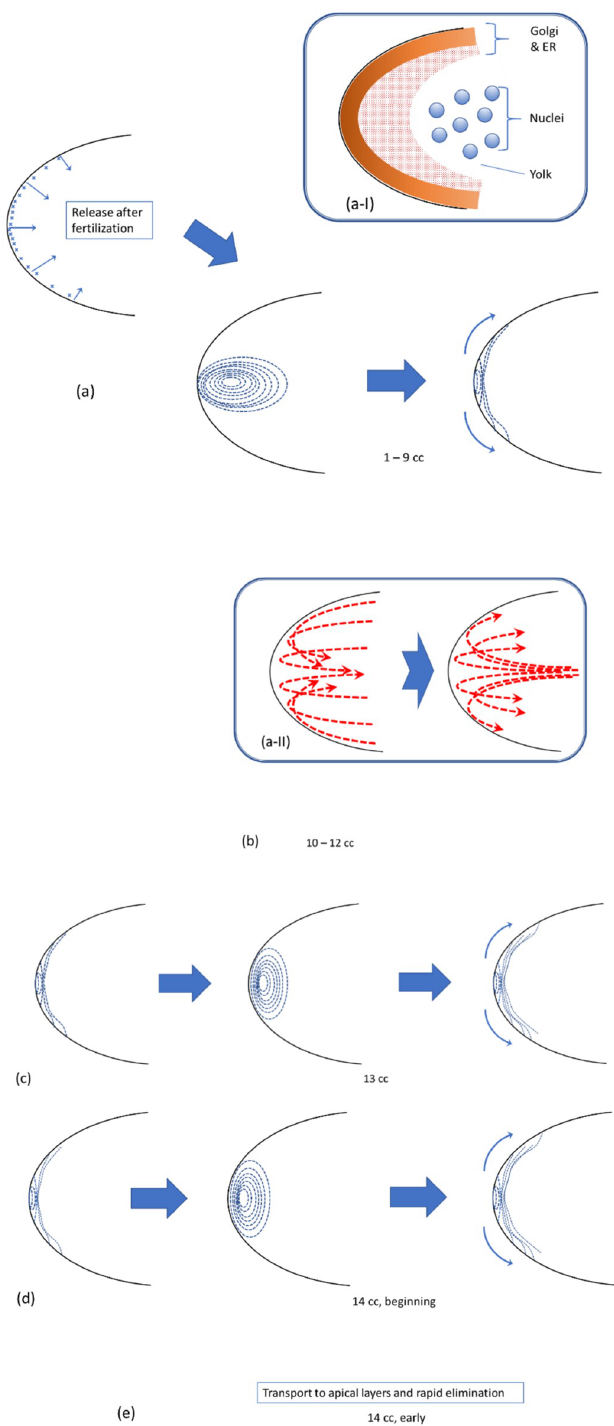
Fig 16. The dynamics of bcd mRNA (in complex with Stau) for the early fly embryo, from its release at the apical cortex (a) as a result of fertilization to the stage of early cycle 14 (e), when fast bcd degradation occurs. See text for